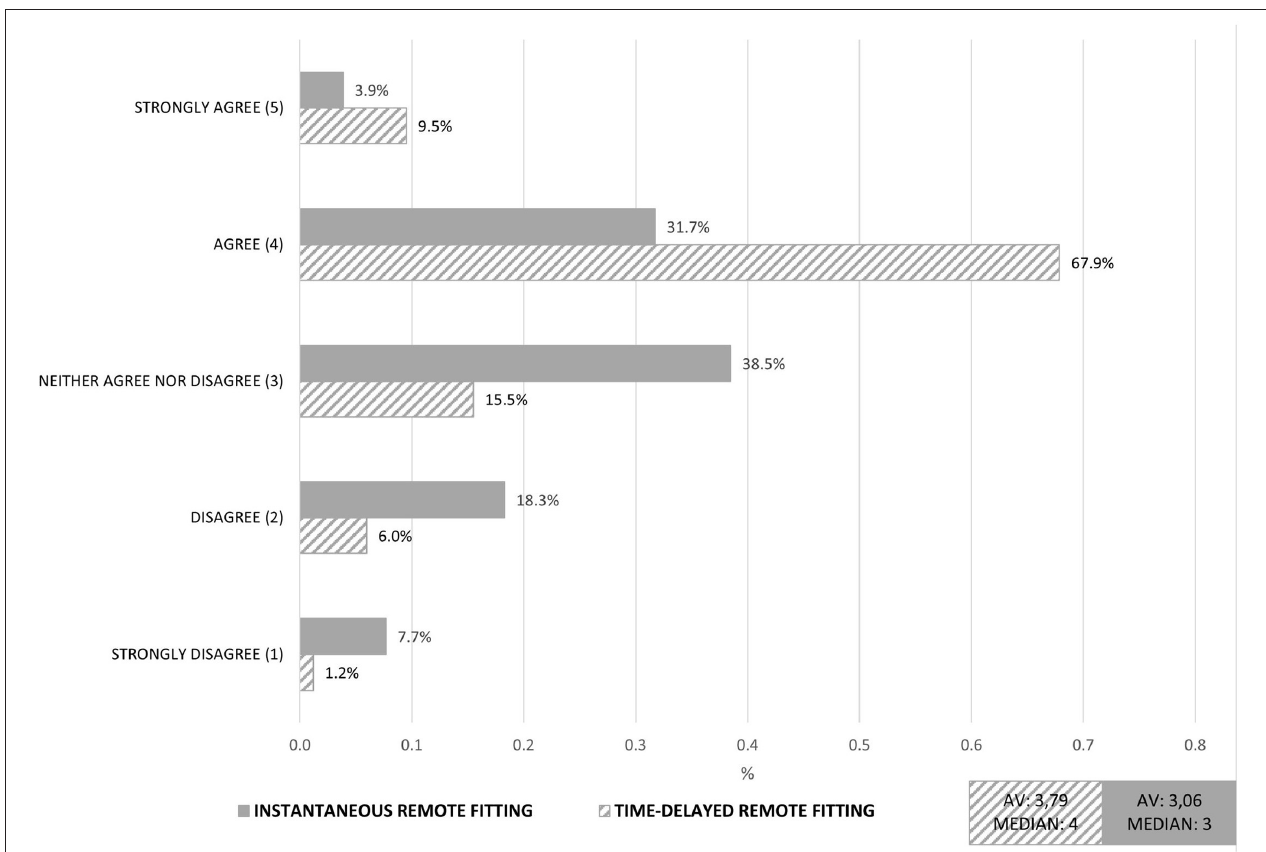
FIGURE 6 | Comparison of instantaneous and time-delayed remote fitting: Aggregated factor Technology Acceptance. Exemplary Item: “I would like to work with the digital service” .